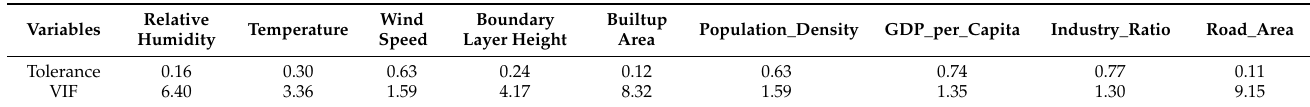
Table A2. The collinearity statistics of the MLR model between ground PM 2.5 and nine selected factors based on the multi-year mean data.